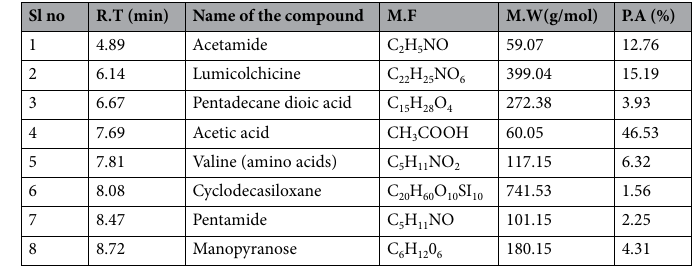
Table 4. Phytochemical components of Palm jaggery Alditol fraction by GC–MS.